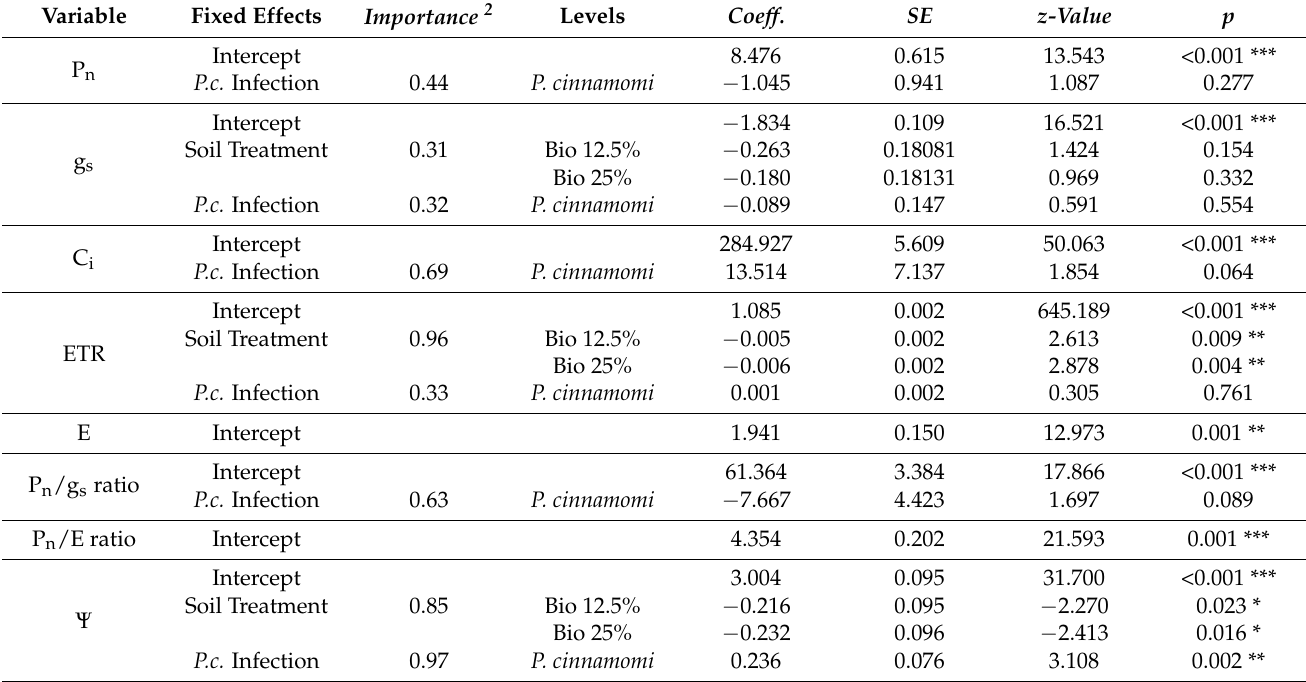
Table 3. Summary of the top linear mixed models ( ∆ AIC < 2) fitted to analyse main factors—soil treatment and P.c. infection—affecting physiological variables (IV models of Table 1). Asterisks indicate statistical significance ( p < 0.05 *, p < 0.01 **, p < 0.001